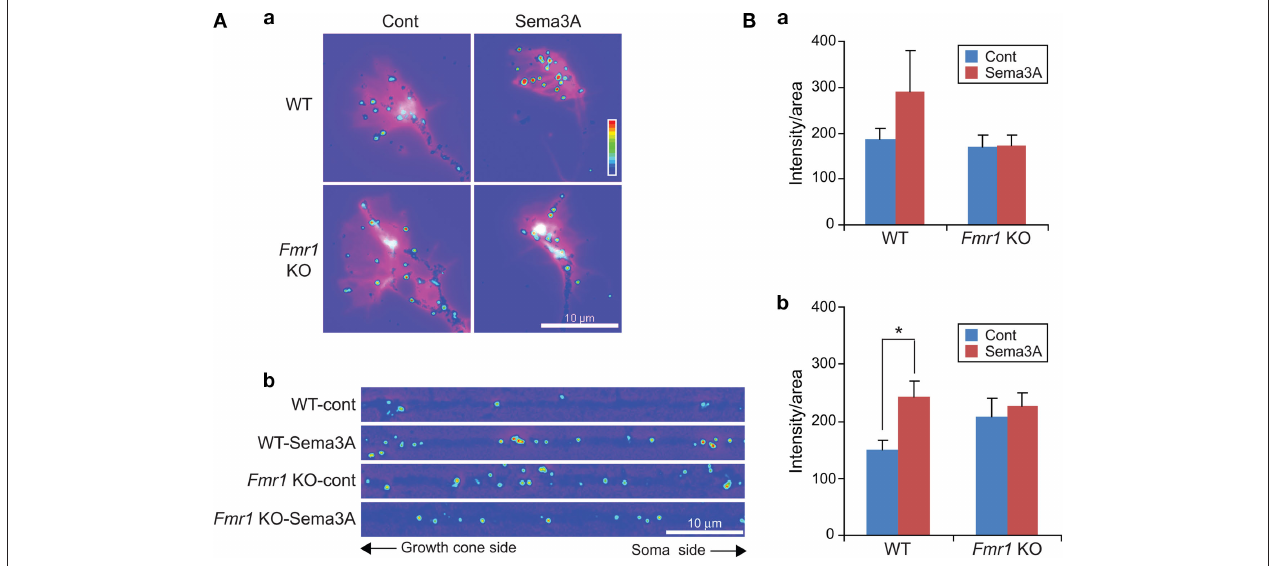
FIGURE 2 | Phosphorylation of eIF4E by Sema3A is attenuated in Fmr1 KO neurons. (A) Immunofl uorescence (IF) images of anti-phospho-eIF4E (Ser209) antibody staining on growth cones (a) and straightened axons (b) treated with or without 1 nM Sema3A for 5 min in WT and Fmr1 KO neurons. The color heat-map bar indicates the intensity of MAP1B IF signal from lowest (purple) to highest